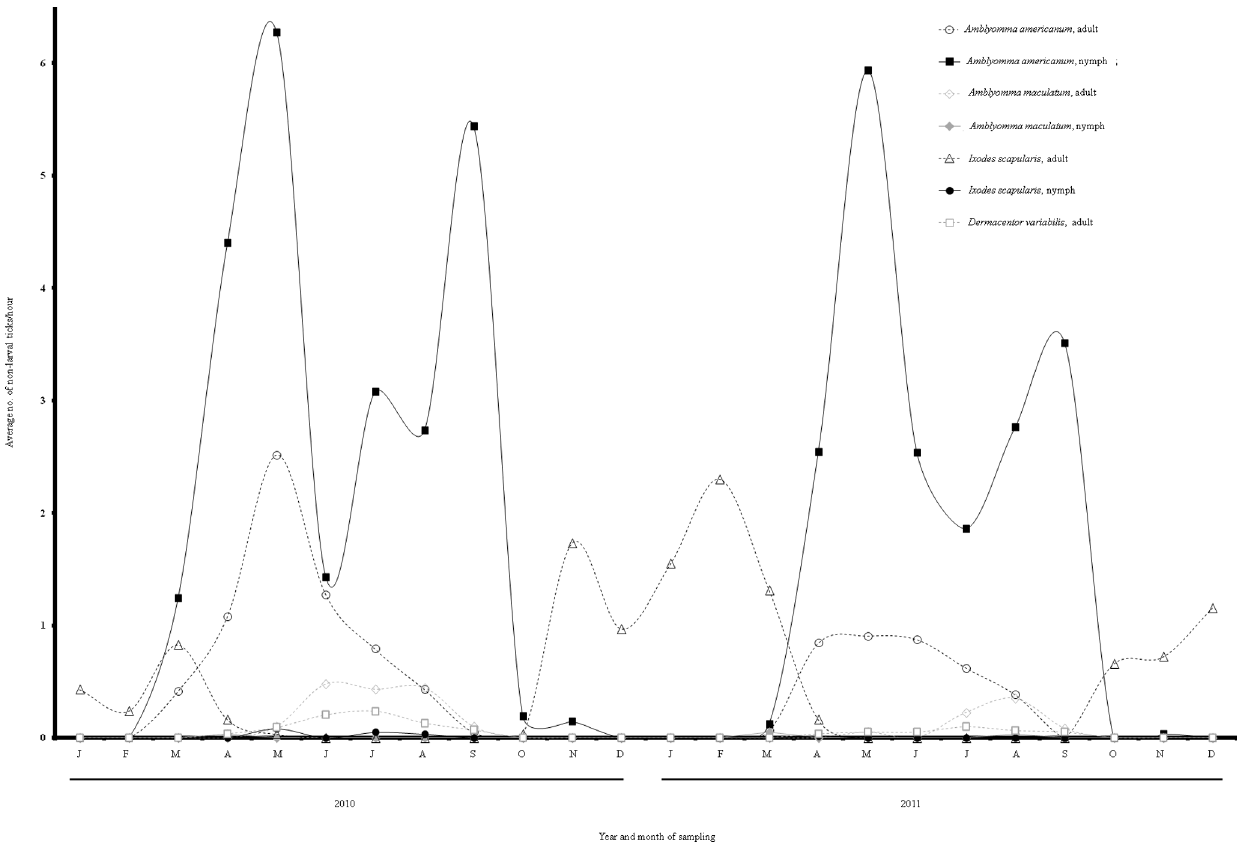
Figure 1. Seasonality of each tick species and life stage across all study plots for 2010 and 2011.